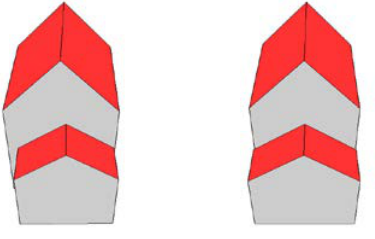
Figure 8. The result of local half-space adjustment (left) and global half-space adjustment with performing 2D feature growing